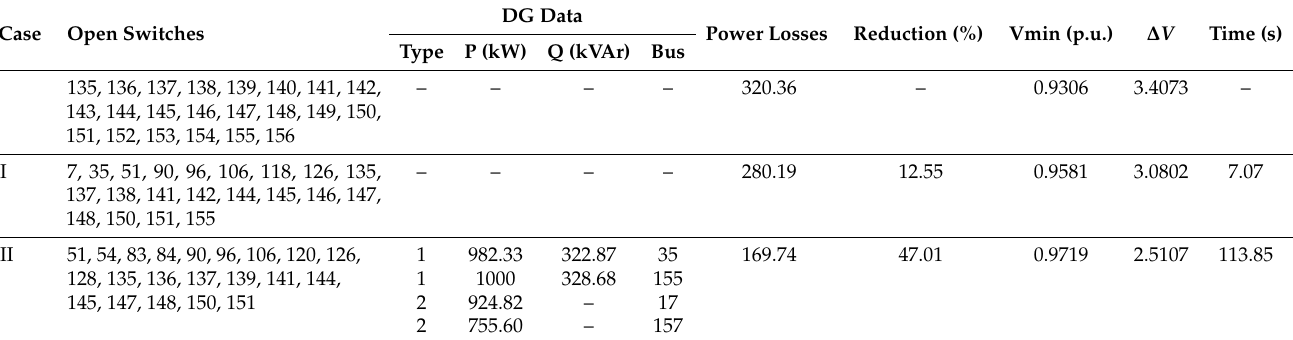
Table 7. Results for the 136-bus test system.